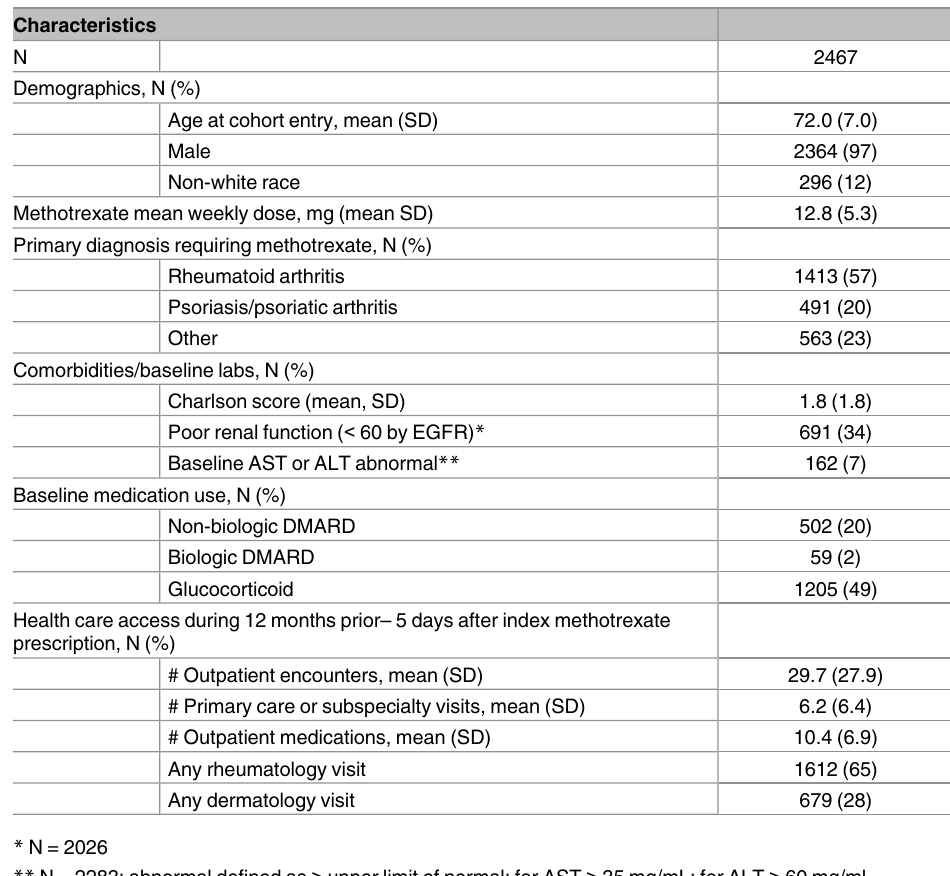
Table 1. Baseline characteristics of incident methotrexate